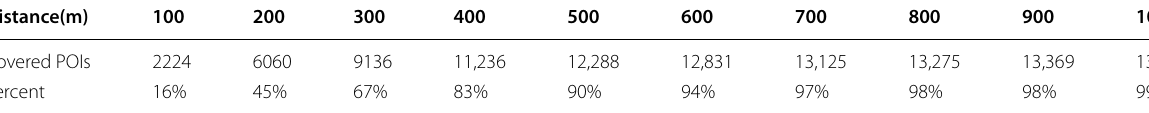
Table 2 Spatial correlation analysis of population density, communities and various express logistics terminals POI Population density Communities Post Shunfeng Jingdong Cainiao Population density 1 0.89245 Communities Post Shunfeng Jingdong 0.53278 Cainiao